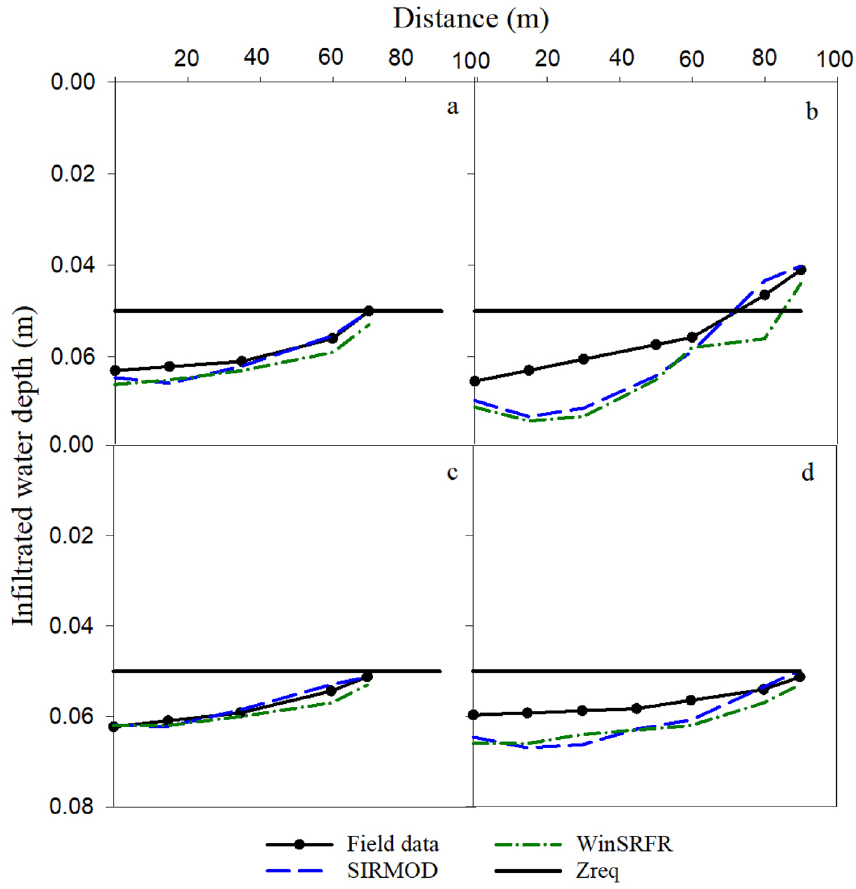
Figure 8. Comparison of the measured and simulated infiltrated depth under surge irrigation ( a . Q 1 L 1 R 0.5 , b .